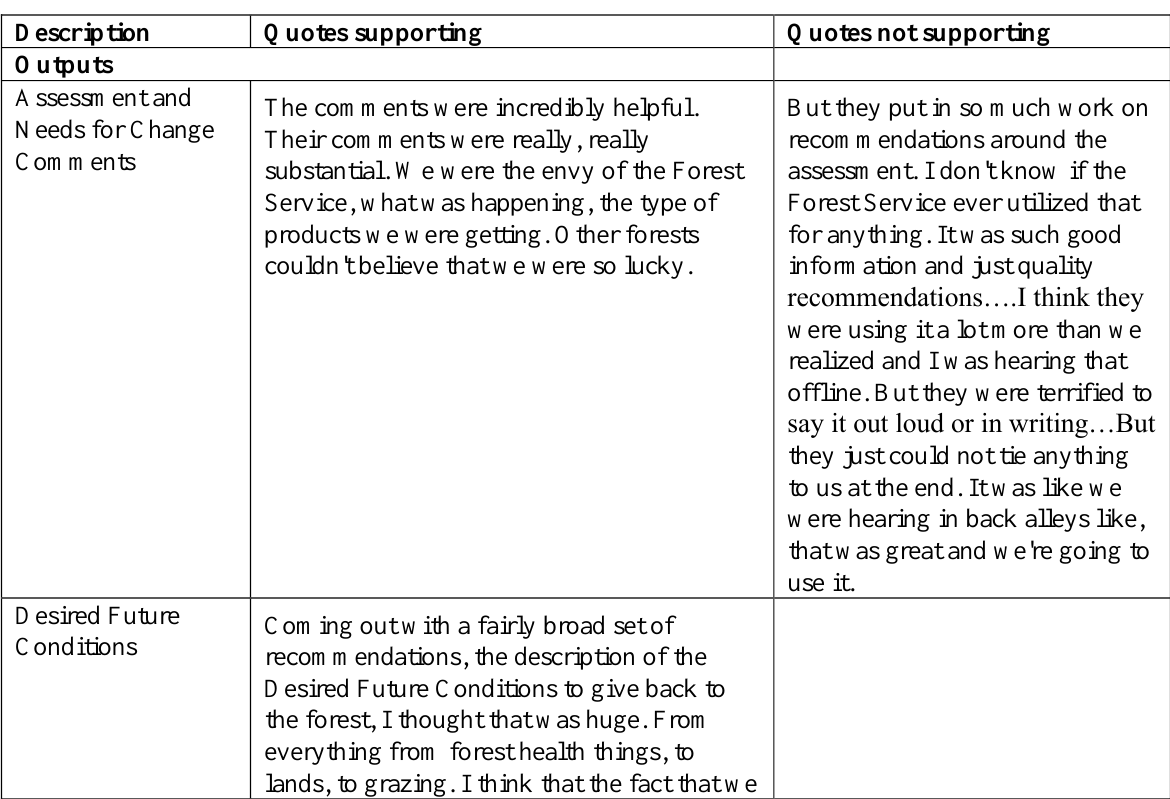
Table A4.2. Evidence supporting and not supporting the main Outputs and Outcomes of the Collaborative. The quotes were selected from interview transcripts to be representative of the range of dominant perspectives reported by interviewees. As stated for Table A4.1, the number of quotes is not intended to provide a quantitative analysis of which perspectives were